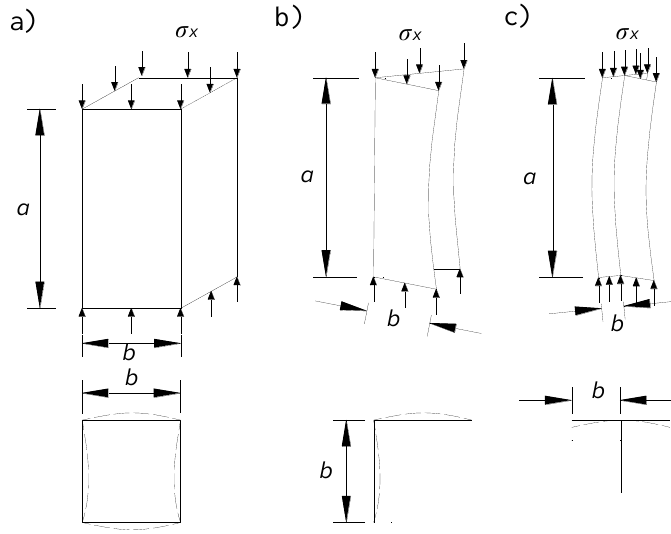
Figure 2. The common cross sections and deformations under compression. a ) Rectangle section; b ) L section; c ) T section.